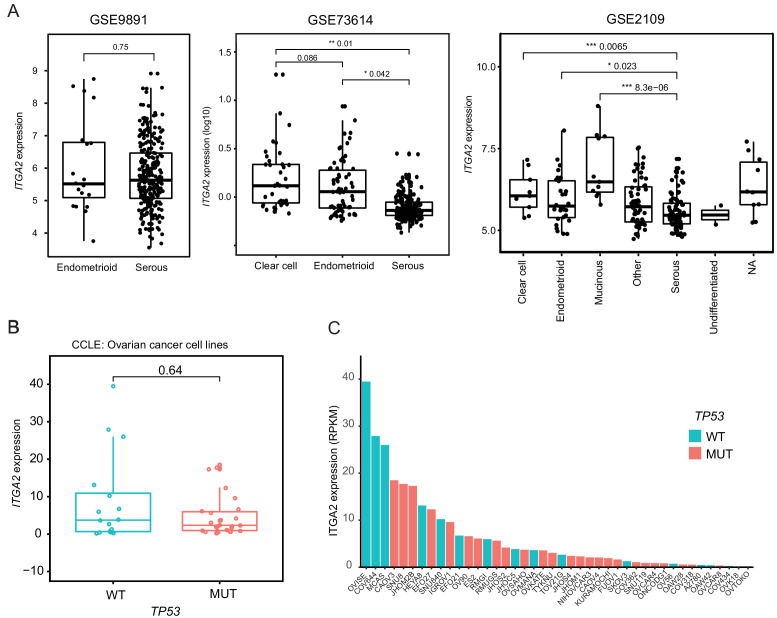
Heterogeneous ITGA2 expression is independent of tumor histotypes and TP53 status in ovarian cancer.(A) ITGA2 expression among ovarian cancer histotypes from GSE9891 (n = 285), GSE73614 (n = 107) and GSE2109 (n = 204) RNA-seq dataset. (B) ITGA2 expression of CCLE ovarian cancer cell lines is independent of TP53 mutational status (p=0.64). (C) Ranked ITGA2 expression (RPKM) and TP53 mutational status in 42 ovarian cancer cell lines.